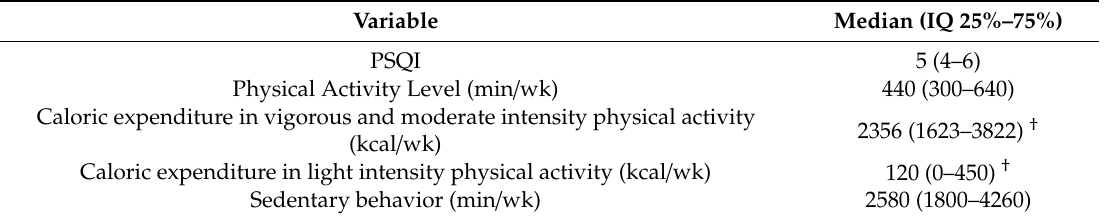
Table 1. Descriptive information of the study participants ( n = 35) regarding the behavioral parameters addressed.